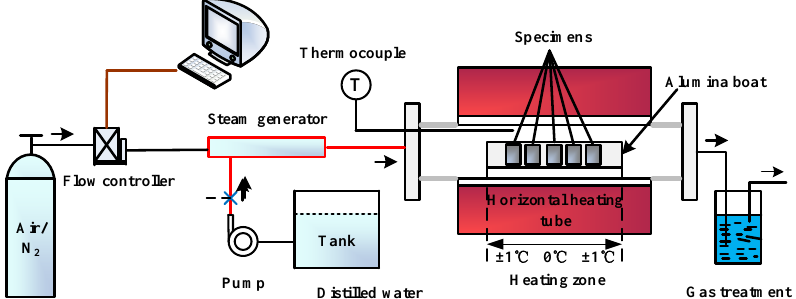
Figure 1. Schematic diagram of the steam oxidation system. Adapted from [26], with permission from © 2015 Spring Nature.